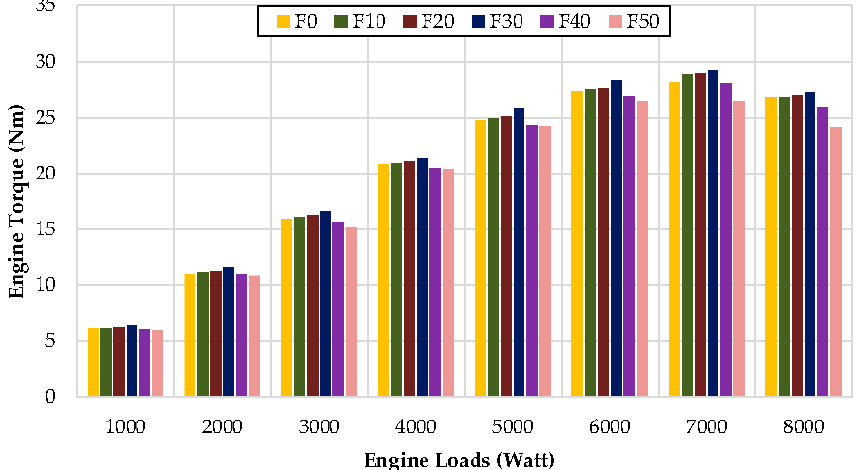
Figure 5. Engine torque changes with engine loads.